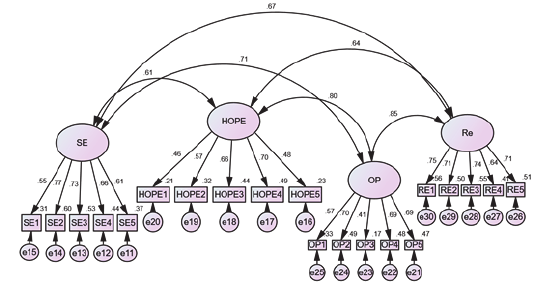
Fig. 3. Regression model for independent dimensions and its coefficients.